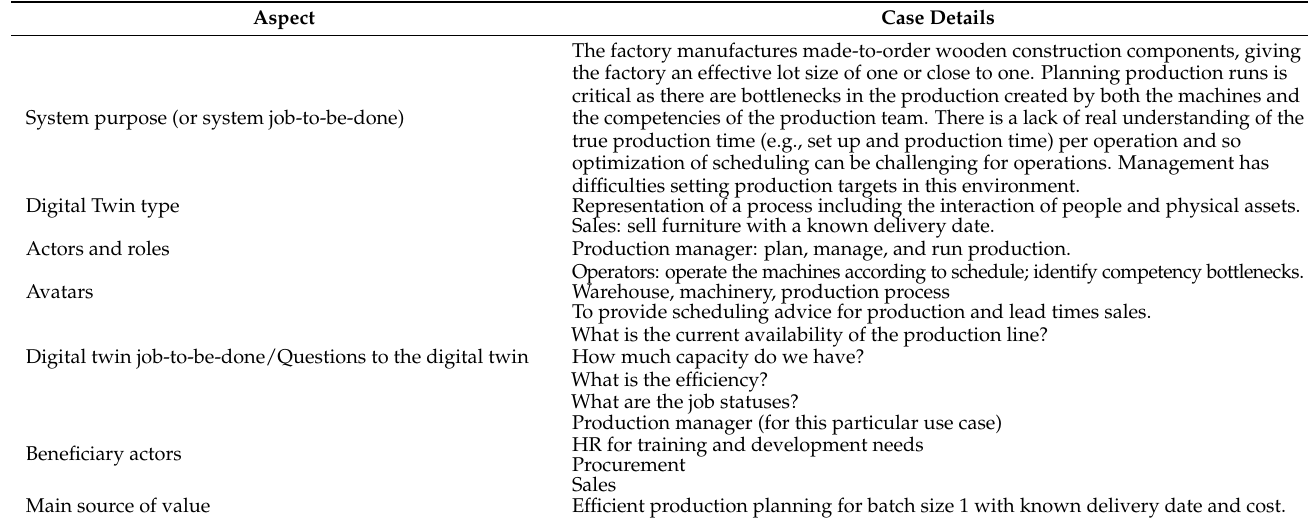
Table A4. Case 2—operations scheduler digital twin for a joinery